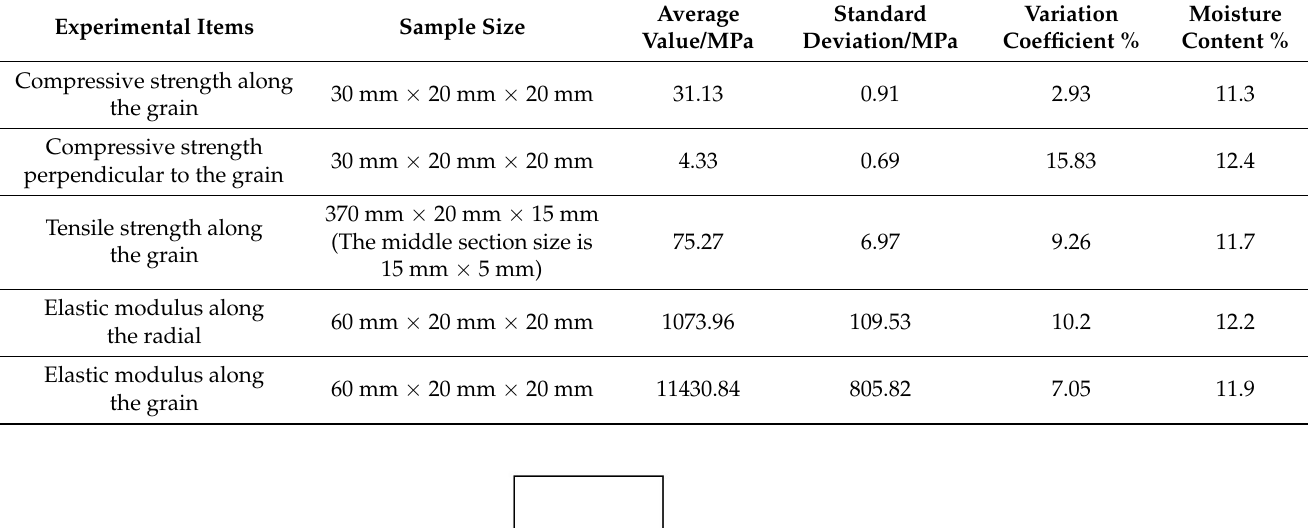
Table 2. Physical and mechanical properties of Chinese fir (Cunninghamia lanceolata).